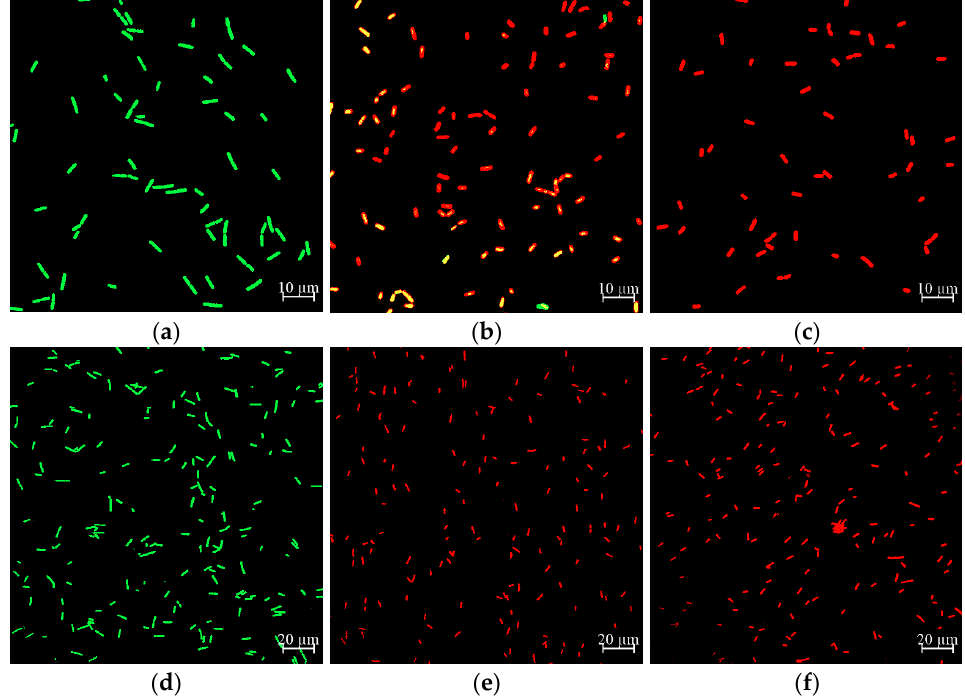
Figure 5. Effect of CA on the cell membrane integrity of Y. enterocolitica and E. sakazakii . ( a ) Untreated Y. enterocolitica , ( b ) Y. enterocolitica treated with MIC CA, ( c ) Y. enterocolitica treated with 2 MIC CA, ( d ) untreated E. sakazakii , ( e ) E. sakazakii treated with MIC CA, and ( f ) E. sakazakii treated with 2 MIC CA.